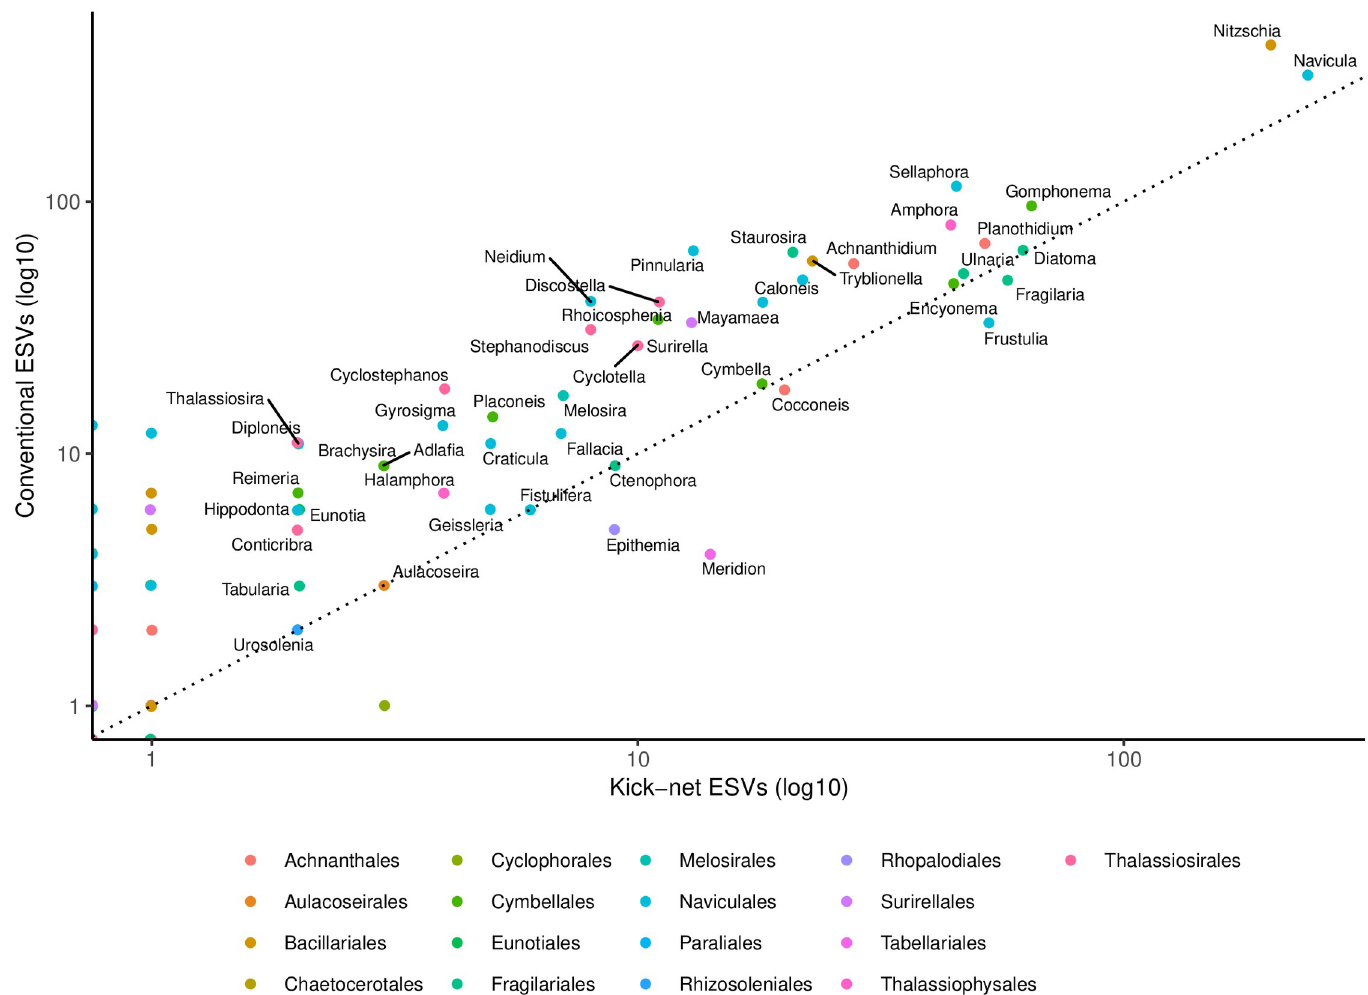
Fig 4. Number of ESVs detected from genera detected from kick-net versus conventionally sampled diatoms are similar. The points are color-coded for the orders detected in this study. A 1:1 correspondence line (dotted) is also shown. A log10 scale is shown on each axis to improve the spread of points with small values. Based on rarefied